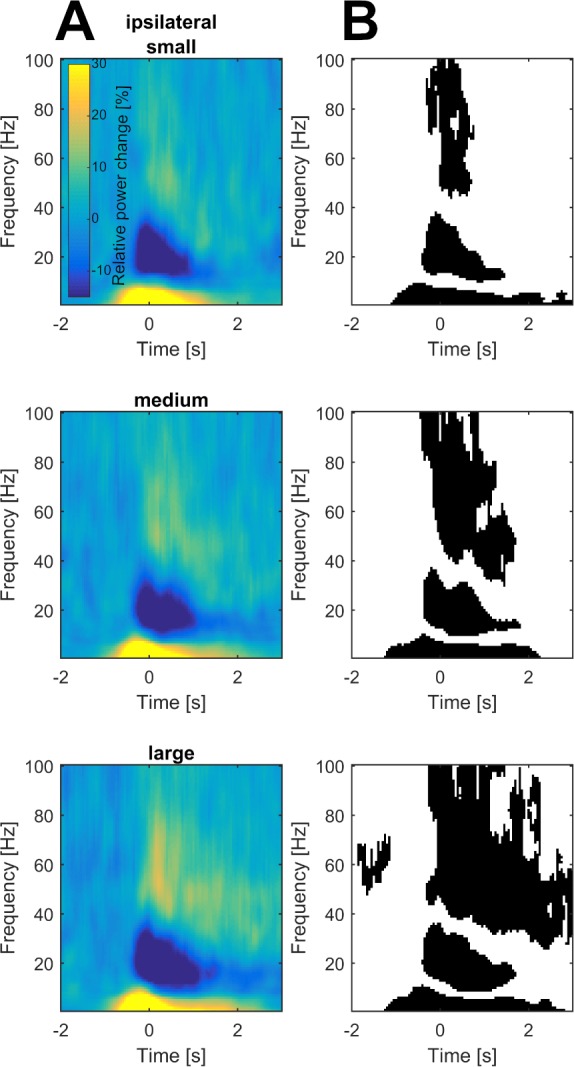
Grand average of subthalamic oscillatory activity in the ipsilateral hemisphere aligned to movement onset in the dopaminergic ON state.Baseline corrected time-frequency representations were averaged across contact pairs and hemisphere in relation to the moved hands (A). Statistical analysis of time-frequency representations across patients revealed significant movement-related modulation from baseline in the theta, beta and gamma band in all conditions (B, p<0.05; FDR corrected).